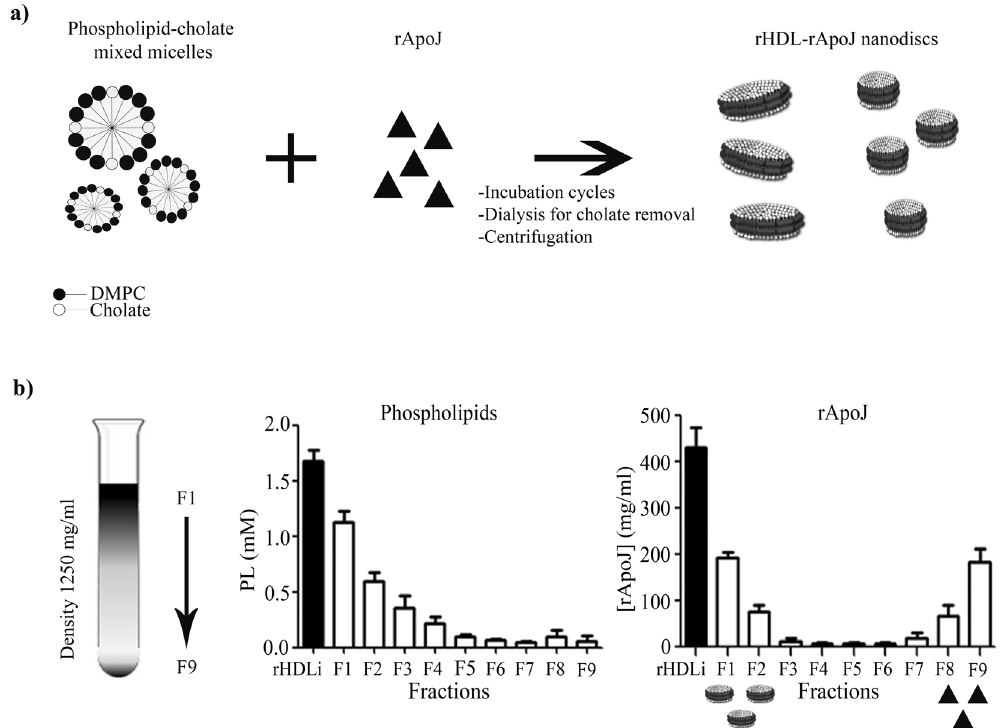
Figure 2. rHDL-rApoJ synthesis and purification. ( a) Schematic representation of rHDL-rApoJ nanodisc synthesis. (b) Schematic representation of the purification process by KBr density ultracentrifugation. Phospholipid and rApoJ (protein) quantification in the different fractions (F1-F9) after the purification process. PL = Phospholipids. N = 6 independent